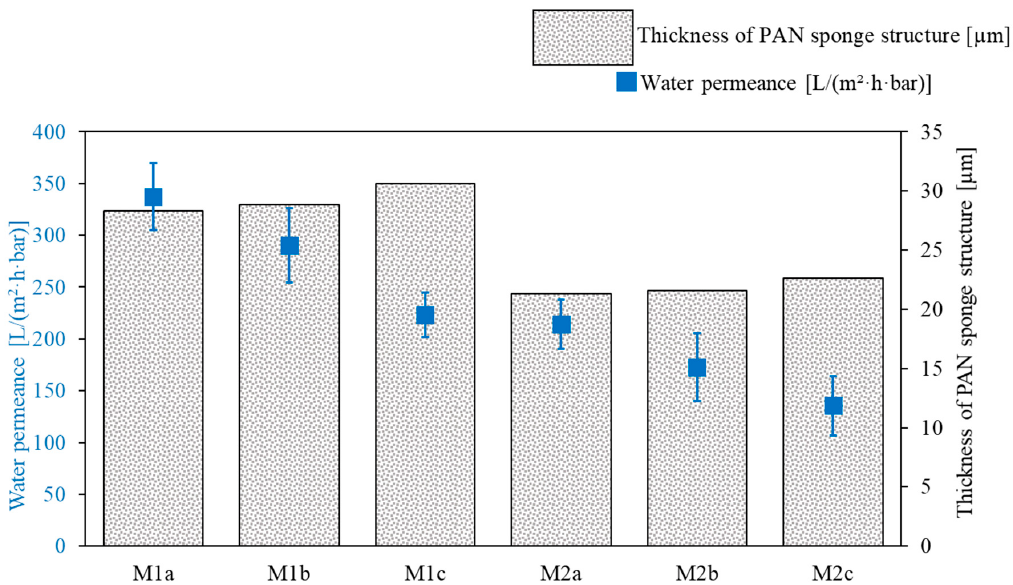
Figure 7. Water permeance and thickness of the PAN membranes M1a–M1c and M2a–M2c used as supports for SILMs.